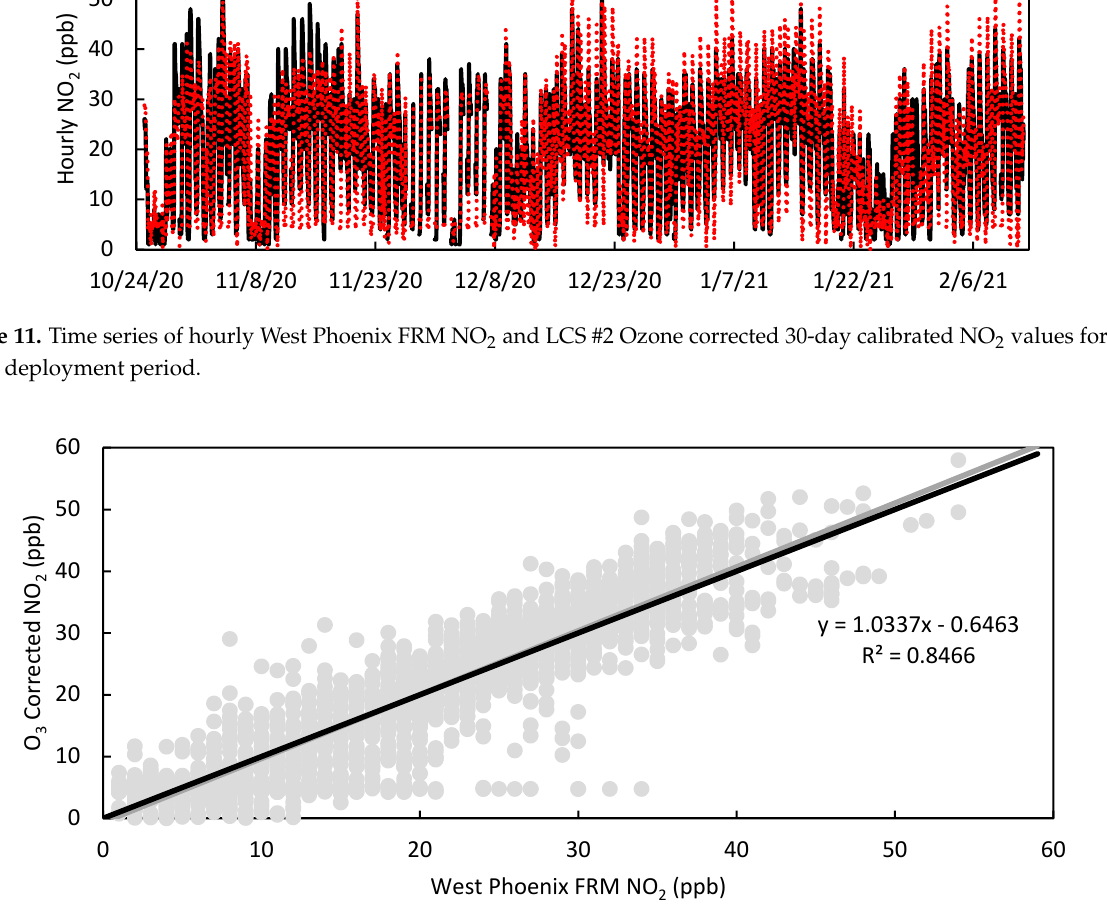
Figure 12 . Scatter plot of hourly LCS #2 Ozone corrected 30-day calibration NO 2 vs. West Phoenix FRM NO 2 with trendline equation and R 2 , 1:1 line in black. Table 5 . Data summary for the Ozone corrected 30-day calibration data from the 8 LCSs collocated at West Phoenix over the entire deployment period, calculated using West Phoenix FRM NO 2 data.